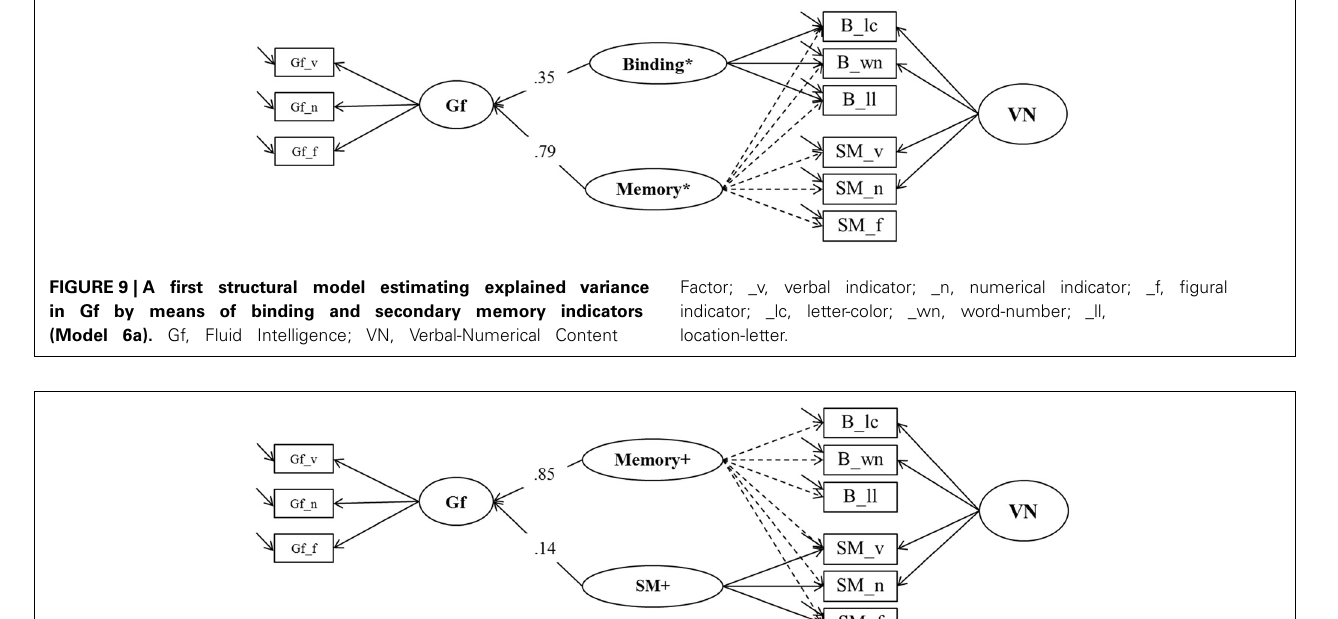
FIGURE 10 | A second structural model estimating explained variance in Gf by means of binding and secondary memory indicators (Model 6b). SM + ,Secondary Memory for Paired Associations; Gf, Fluid Intelligence; VN,